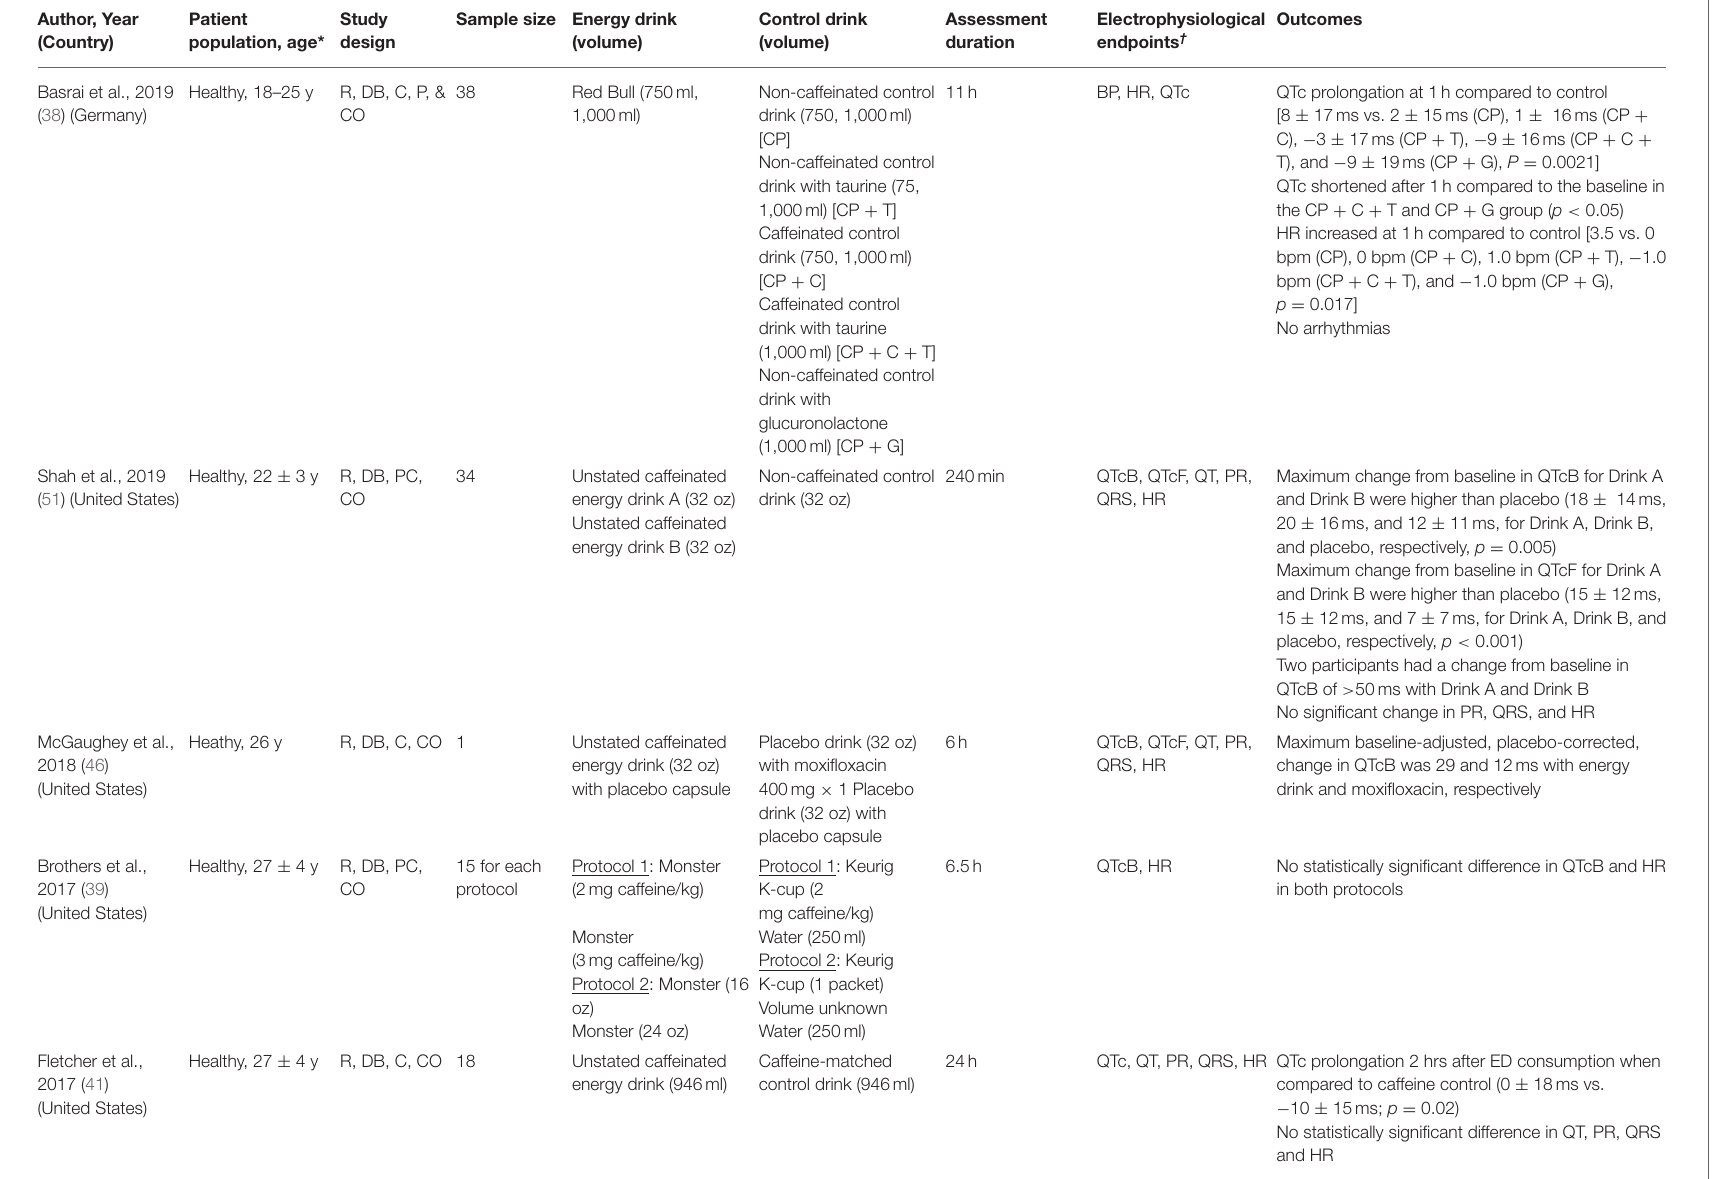
TABLE 2 | Clinical trials of energy drinks and related electrophysiological and ischemic abnormalities (36–54). Author, Year (Country)